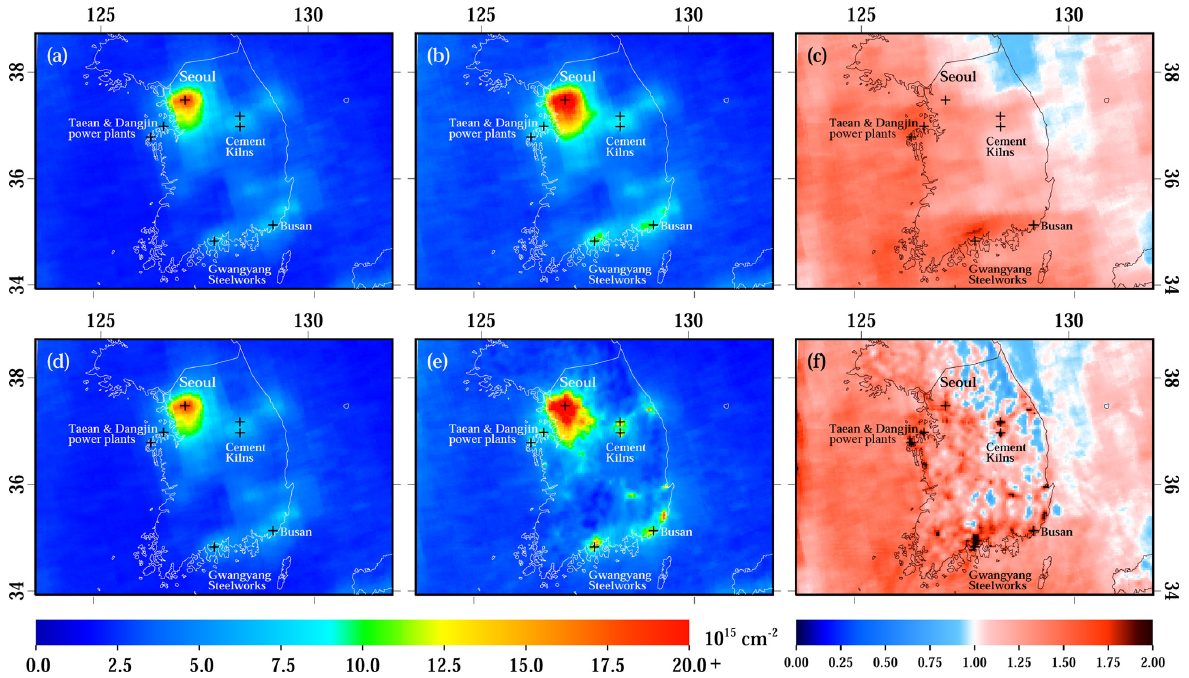
Figure 2. (a) OMI-standard NO 2 product averaged over a 9-month period, April–June 2015–2017, (b) the OMI-regional NO 2 product with only the air mass factor adjustment averaged over the same time frame, and (c) the ratio between the two products: (b) / (a) . (d) Same as (a) , (e) the OMI-regional NO 2 product with the air mass factor adjustment and spatial kernel averaged over the same time frame and (f) the ratio between the two products: (e) / (d) .